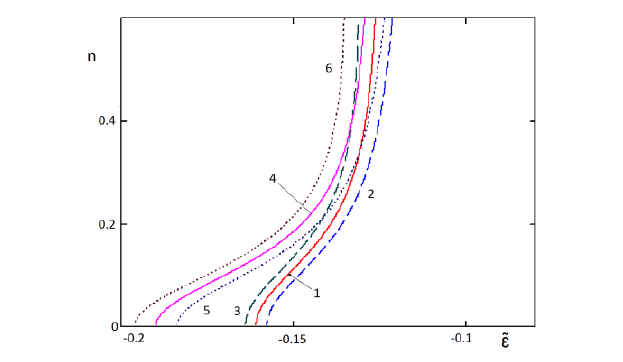
Figure 1. The NLSP propagation constant n vs. the permittivity at the surface of the nonlinear medium   . The saturation level is